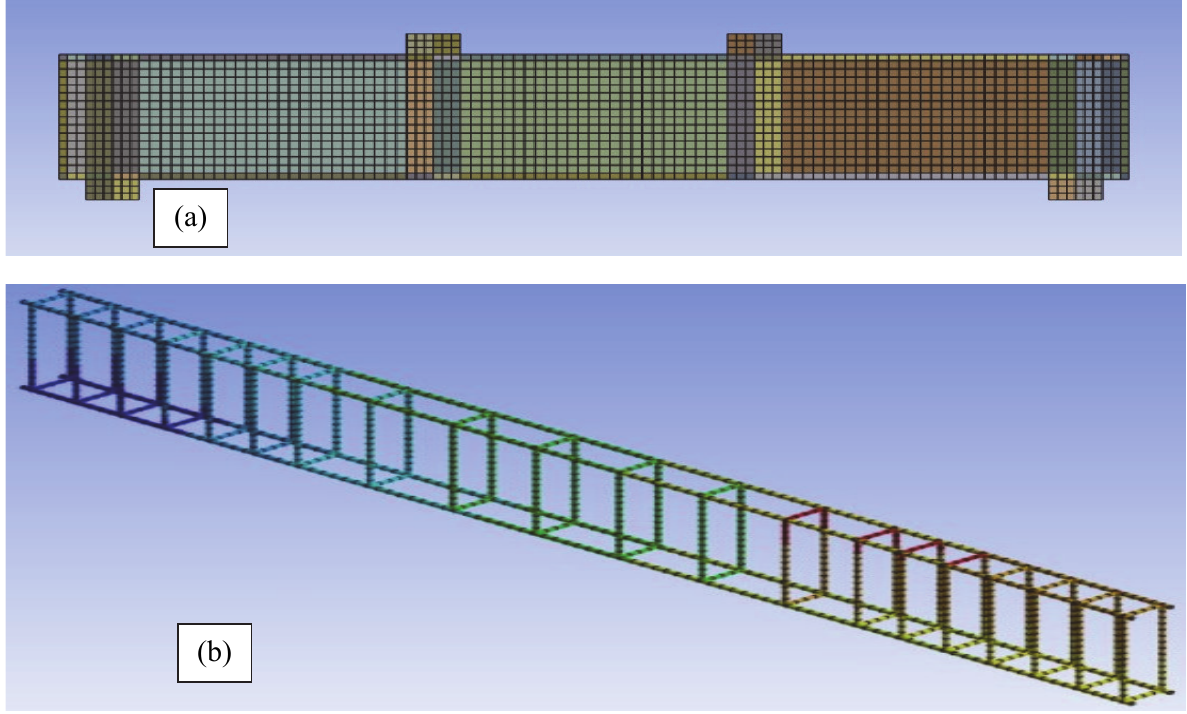
Figure 14: (a) Sample representation of developed FE models., (b) different elements of the beam modelled.